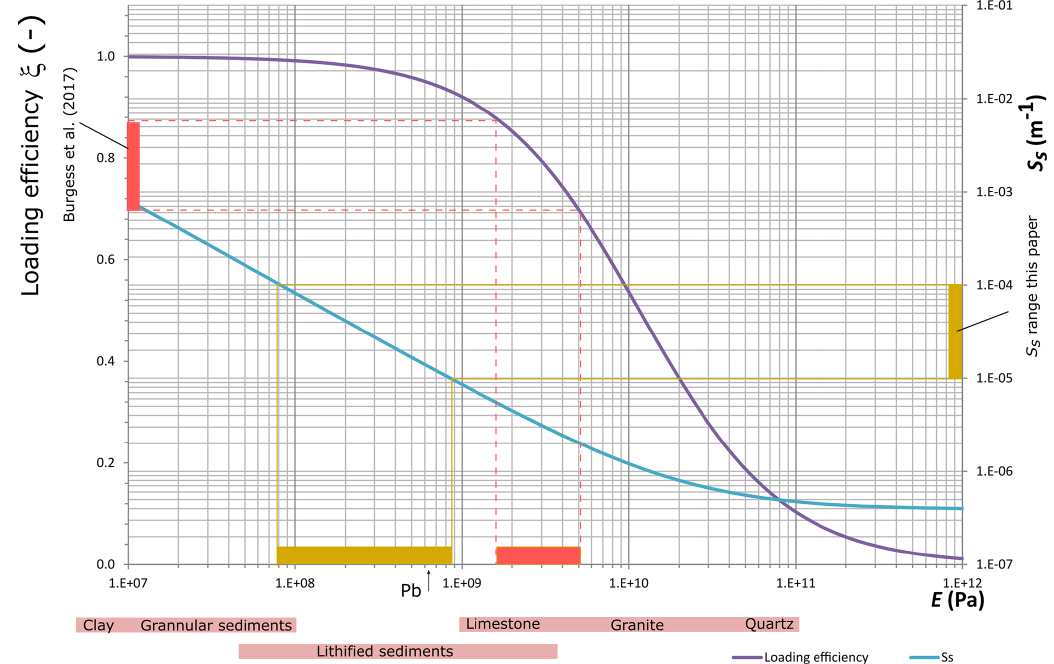
Figure 3. Relationship between 1-D specific storage ( S s ), Young’s modulus ( E ), and 1-D loading efficiency ( ξ ) using Eqs. (A3), (A4), and (A5) assuming a porosity of 0.1 and Poisson’s ratio of 0.25. Projections show the corresponding inferred ranges of E based on the S s range applied (1 × 10 − 5 –1 × 10 − 4 m − 1 ) and the loading efficiencies calculated via barometric efficiency estimates (0.69–0.87) by Burgess et al. (2017). Pink bars show indicative ranges for common geological materials. Arrow indicates data from 73m depth at Padma Bridge (Pb) (de Silva et al.,